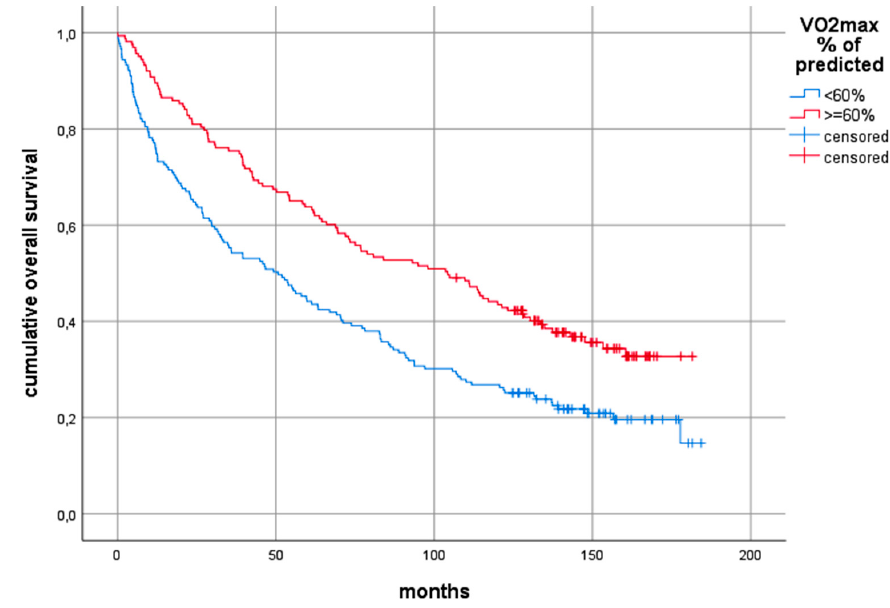
Figure 1. Kaplan–Meier curves comparing the overall 10-year survival between those patients with predicted VO 2 peak >= 60% and those with predicted VO 2 peak < 60%. Log-rank test: chi 2 = 16.46, p < 0.0001. Abbreviations: VO 2 peak: preoperative peak oxygen consumption.